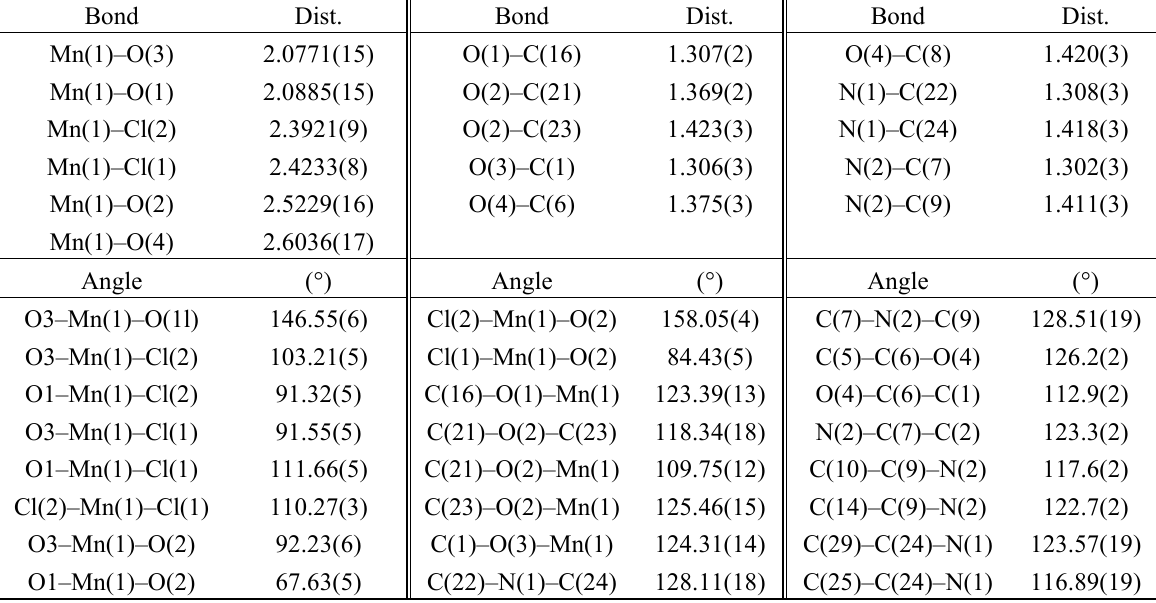
Table 5. Selected Bond Lengths (Å) and Bond Angles (°) for Complex